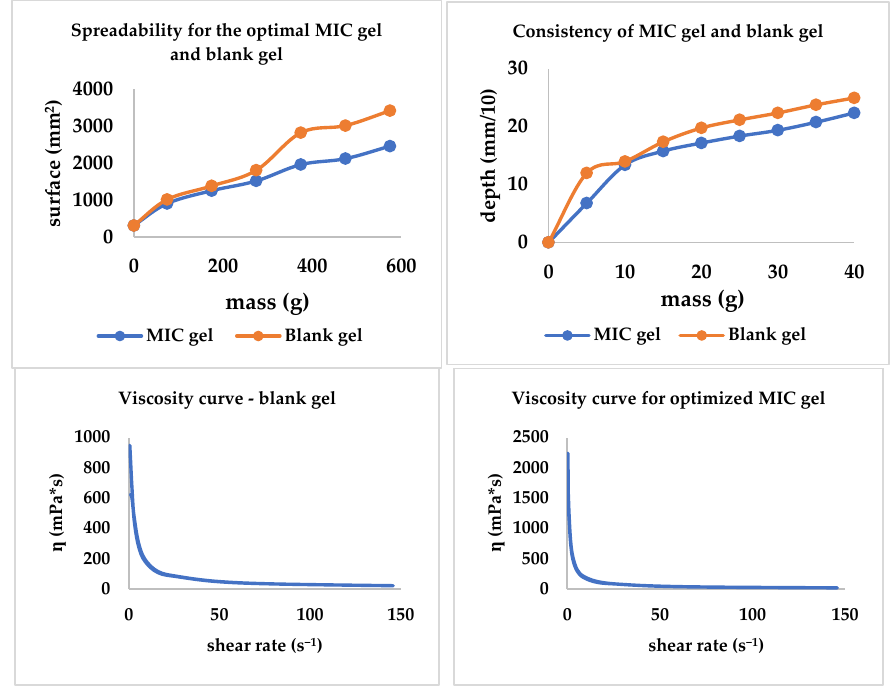
Figure 8. The consistency, spreadability, and viscosity curves for the optimized gel and the blank gel with the same composition.